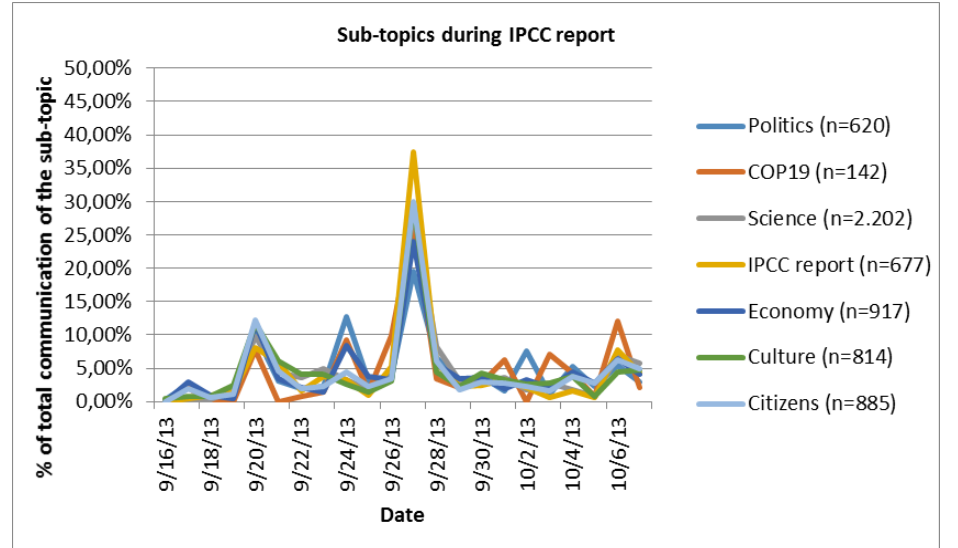
Figure 5. Dynamics of sub-topics during the release of the IPCC report